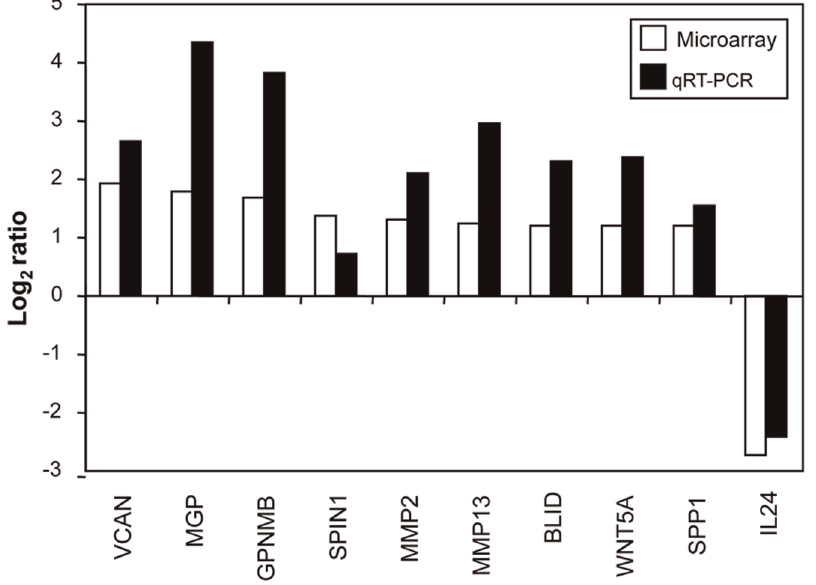
Figure 7. qRT-PCR analysis of genes selected from the microarray profile. Expression changes of 10 selected genes were evaluated in relation to the values obtained in parallel for SHDA. Log2 scale of fold change was used to show the relative expression value of each gene. Positive values indicate that the mRNA level of a particular gene was up-regulated, whereas negative values indicate that the transcript was down-regulated.